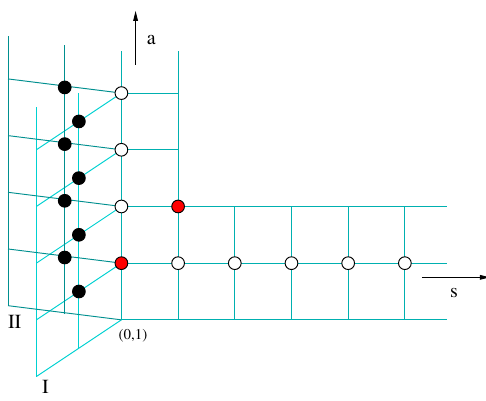
Figure 7 . Domain of de(cid:12)nition of the T-system (A.1){(A.3). In our notations, T functions be- longing to the two wings of the diagram are distinguished by the superscript (cid:11) 2 f I; II g